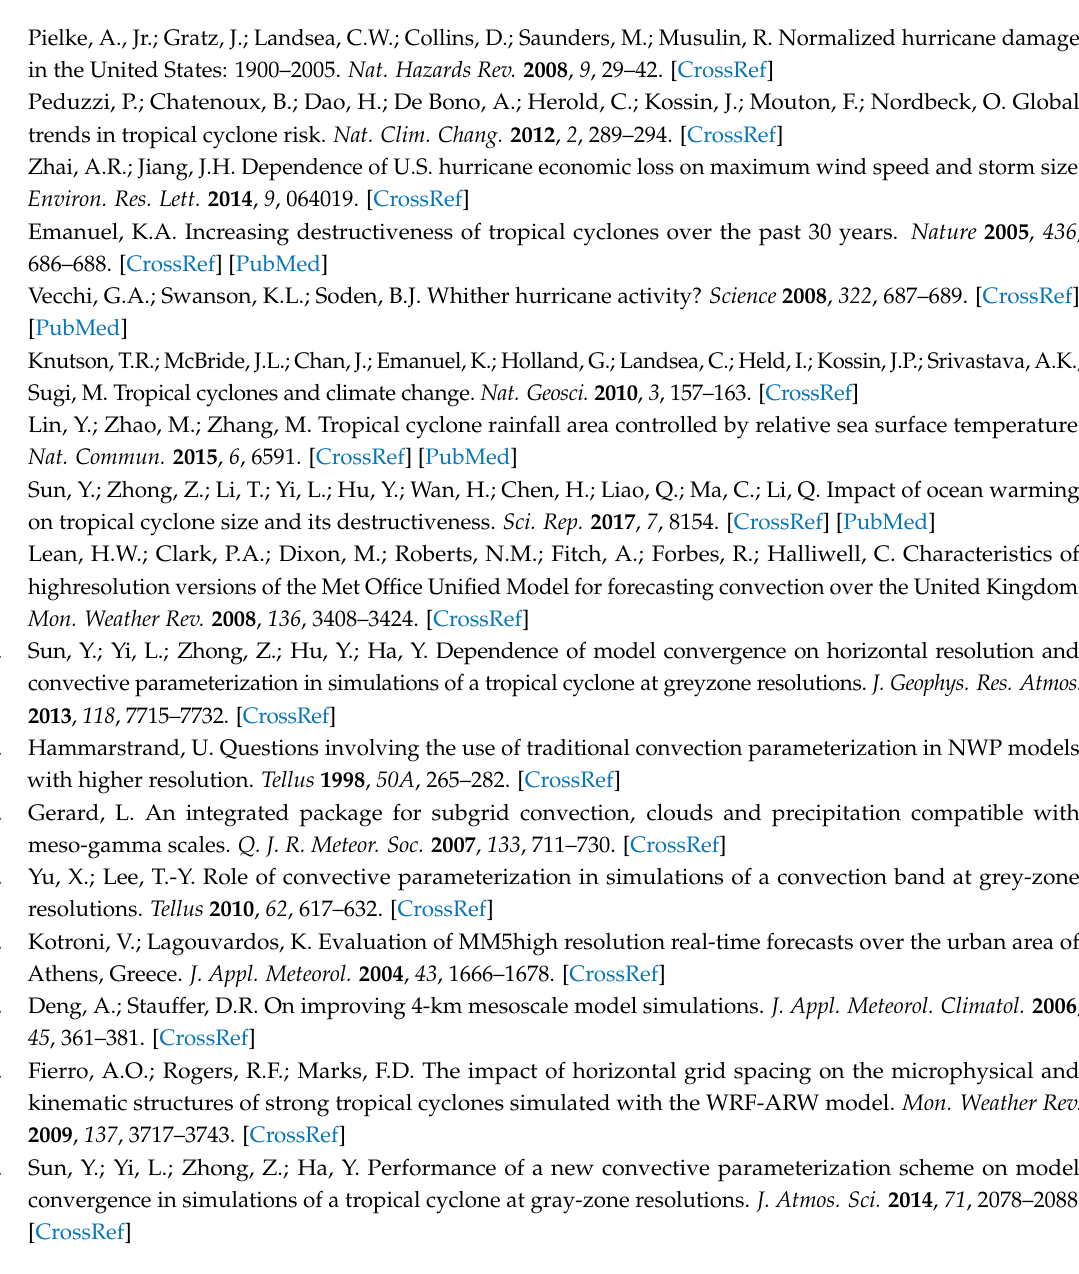
Figure S5: Rainfall rate (inches h-1) from TRMM TMI/PR at 0431 UTC 16 September 2006. Figure S6: Azimuthal- and time-averaged cross-sections of radial wind (m s-1) in the TC mature